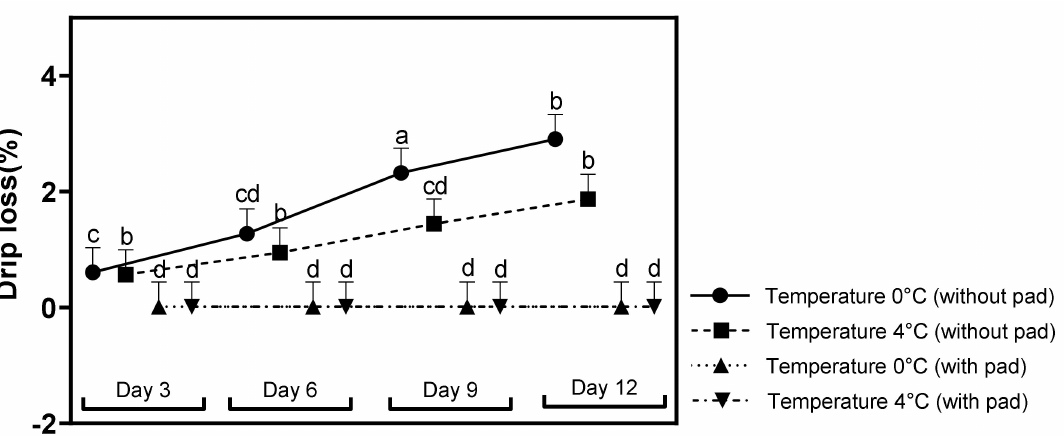
Figure 4. Effect of the interaction of storage temperature, with or without absorbent pads, and storage duration (d) on drip loss for active-MA packaged fillets; different letters indicate a significant difference ( p < 0.001).